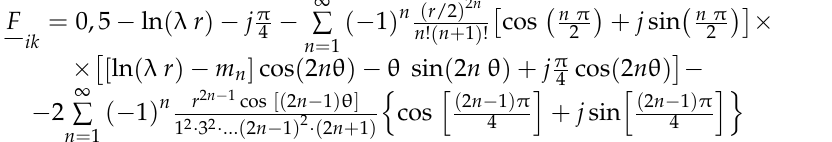
Figure 5. Original circuit of the power transmission line.